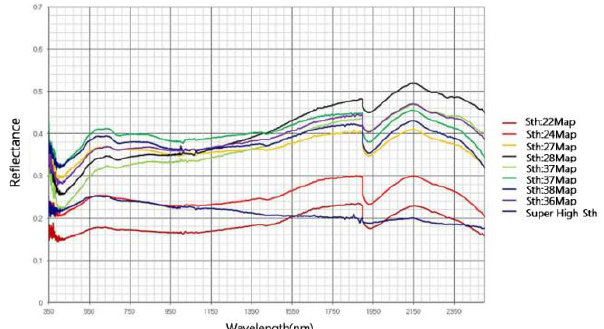
Figure 4. Spectral reflectance of concretes according to